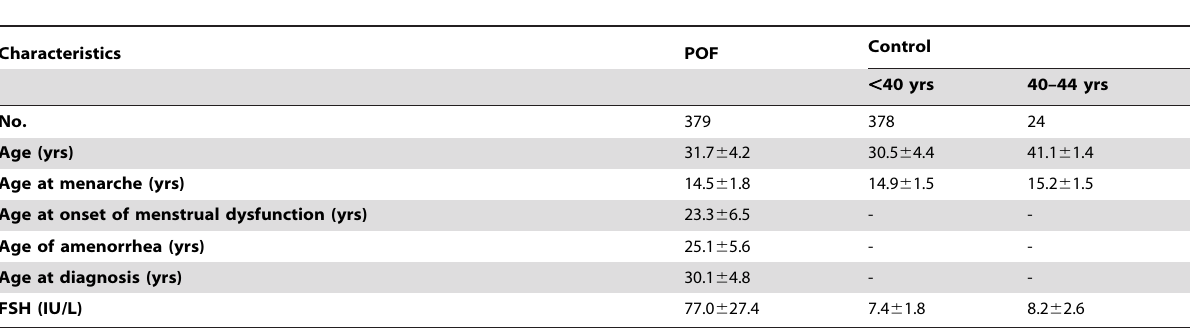
Table 1. Clinical characteristics of POF patients and